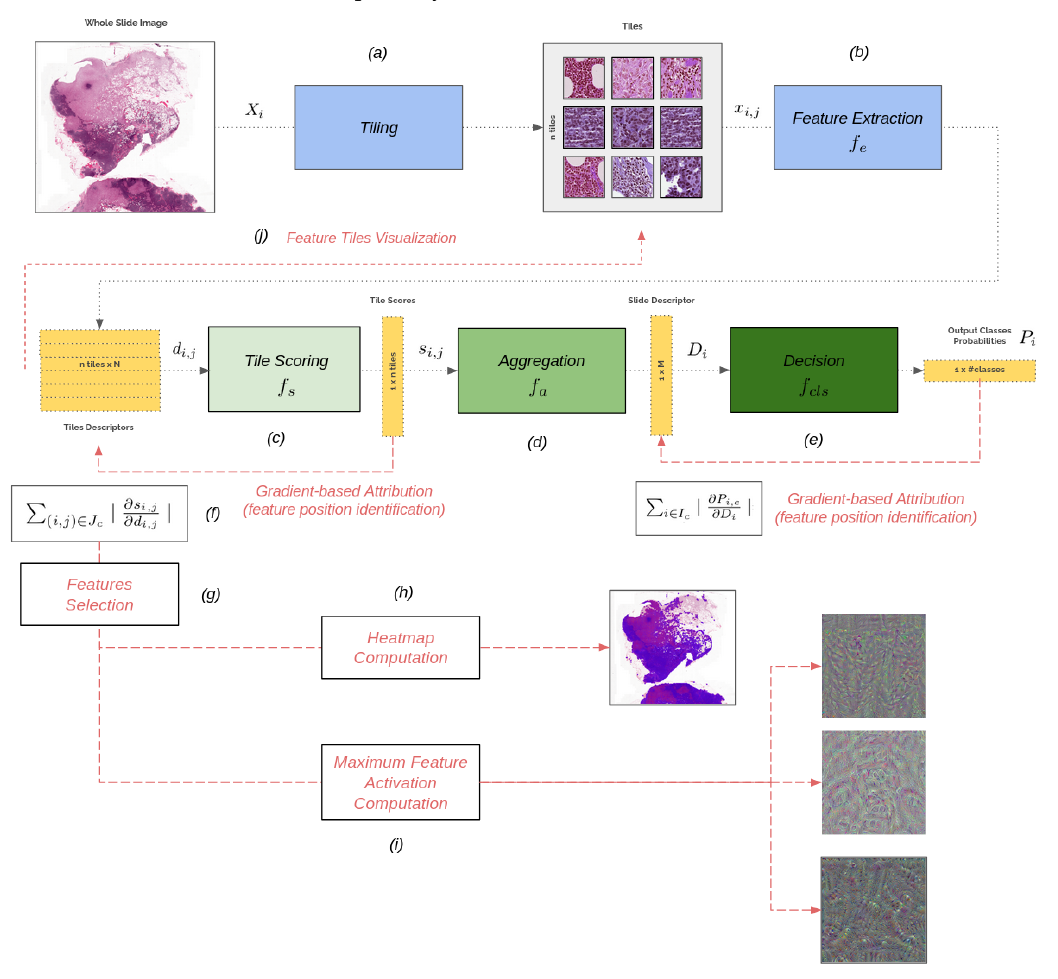
Figure 2. Overview of the proposed method. Whole Slide Imaging (WSI) classification: ( a ) Tiling from the slide; ( b ) Features extraction from the tiles; ( c ) Tile scoring from tile descriptors; ( d ) Aggregation; ( e ) Decision from the slide descriptor; Interpretability (in red): ( f ) Feature identification from gradient-based attributions; ( g ) Feature selection from feature colocalization; ( h ) Heat-map computation from activation of selected features; ( i ) Individual feature visualization through gradient ascent; ( j ) Individual feature visualization through tile feature